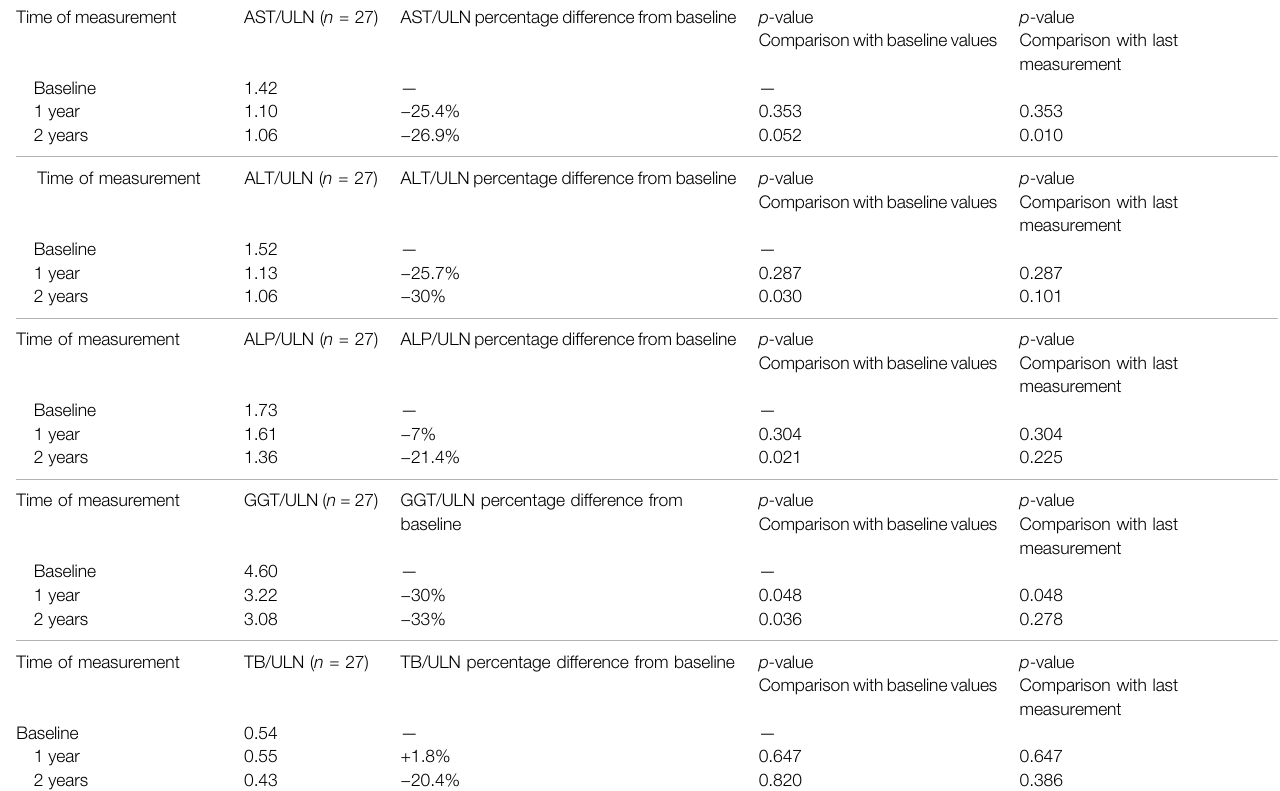
TABLE 2 | Median paired biochemical changes overtime after the introduction of fi brates Time of measurement p -value